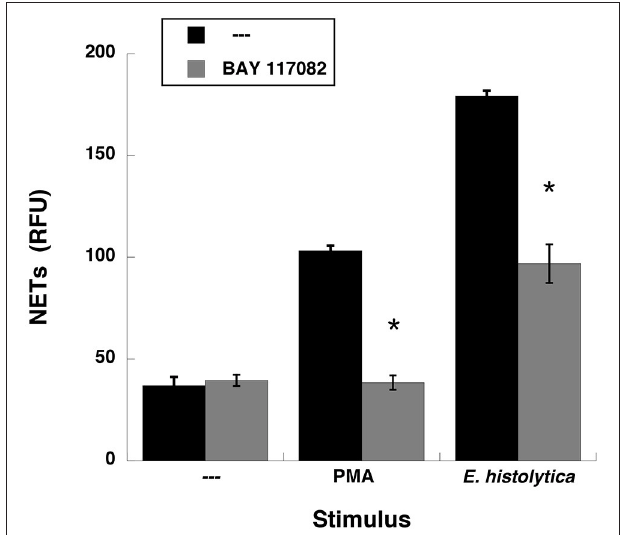
FIGURE 11 | Entamoeba histolytica- induced NET formation is dependent on NF- κ B. Human neutrophils were not stimulated (—), or were stimulated with 20 nM phorbol 12-myristate 13-acetate (PMA), or with E. histolytica trophozoites. Neutrophils were previously treated with solvent alone (—) or with the NF- κ B inhibitor BAY 117082 at 5 µ M. The relative amount of NETs was estimated from SYTOX ® Green fluorescence in relative fluorescent units (RFU) at 4h after stimulation. Data are mean ± SEM of four experiments. Asterisks denote conditions that are statistically different from control ( p <